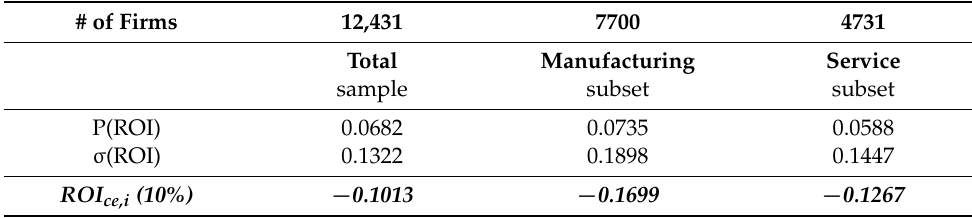
Table 6. Confident equivalent